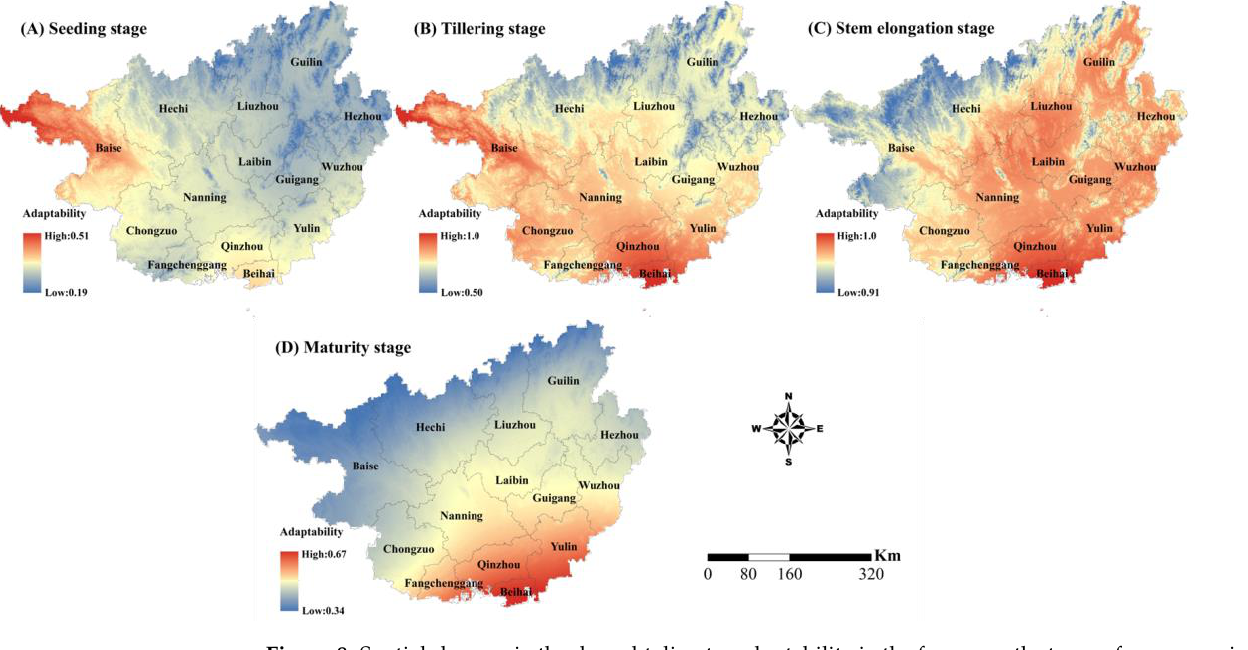
Figure 8. Spatial changes in the drought disaster adaptability in the four growth stages of sugarcane in Guangxi. ( A – D ) represent the stages of seedling, tillering, stem elongation, and maturity, respec- tively.